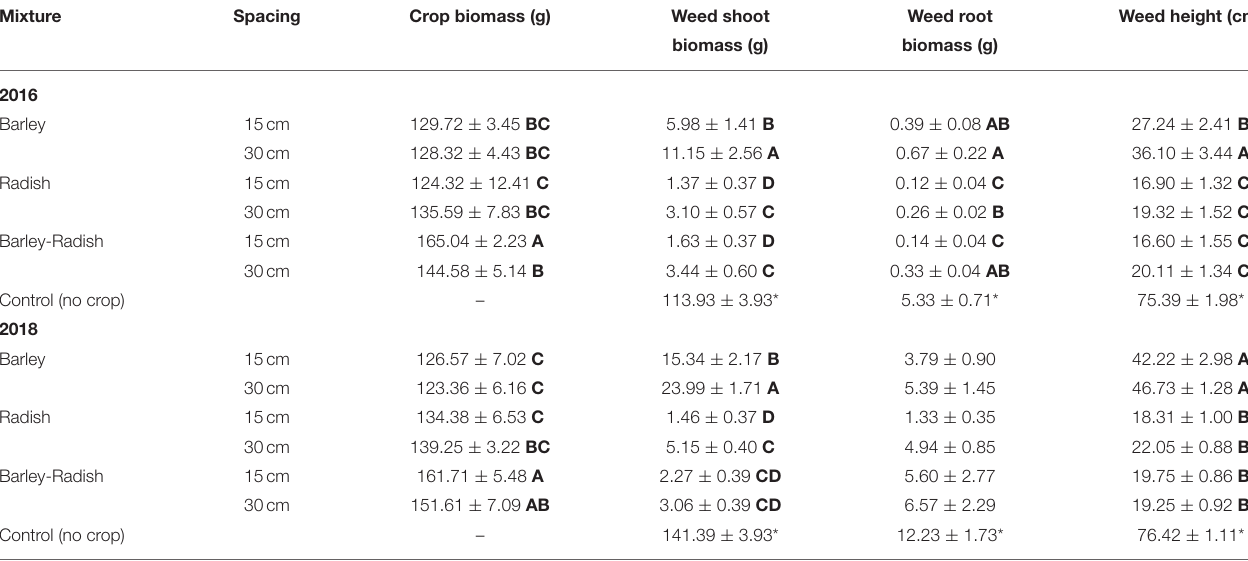
TABLE 7 | Mean crop biomass, weed shoot biomass, weed root biomass, and weed height with crop mixture and row spacing for the 2016 and 2018 greenhouse experiments.